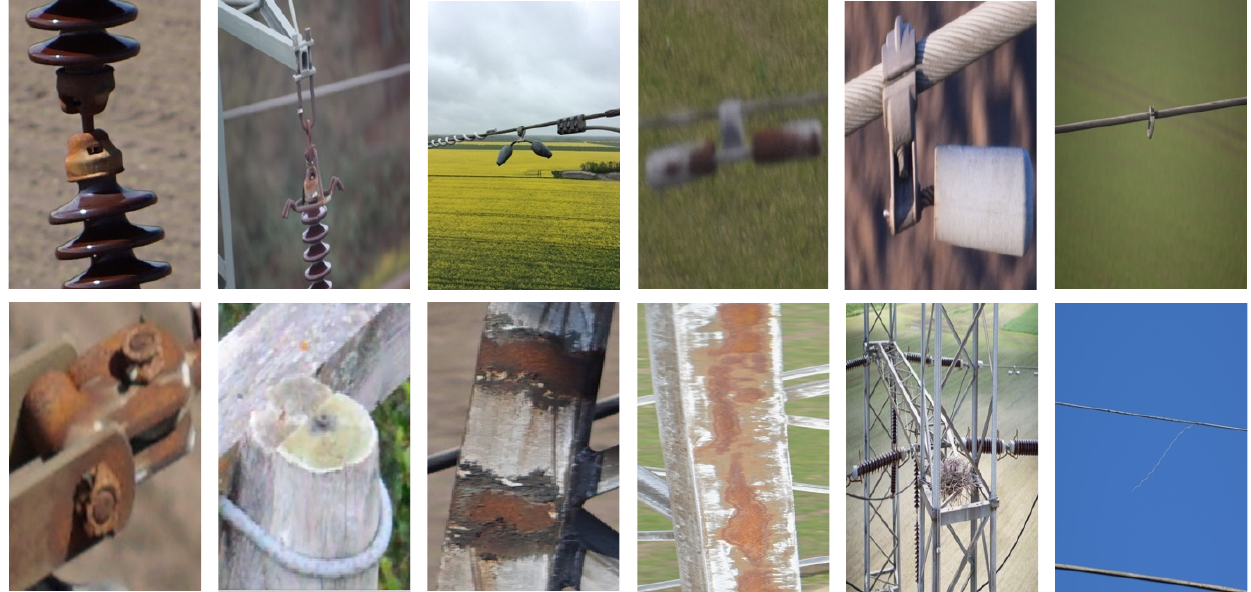
Figure 2. Sample images of the most common faulty components used to train the DL model (from top left to bottom right): Insulator Rust Type 1, Insulator Rust Type 2, damaged vibration dampener, rusted vibration dampener, broken vibration dampener, missing vibration dampener, rusted nut-bolt, missing top pads [2], Pylon Corrosion Type 1, Pylon Corrosion Type 2, bird’s nest, and broken wire,